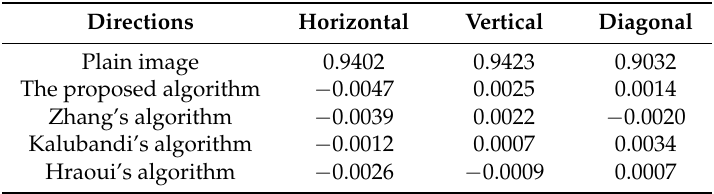
Table 3. Correlation coefficients.